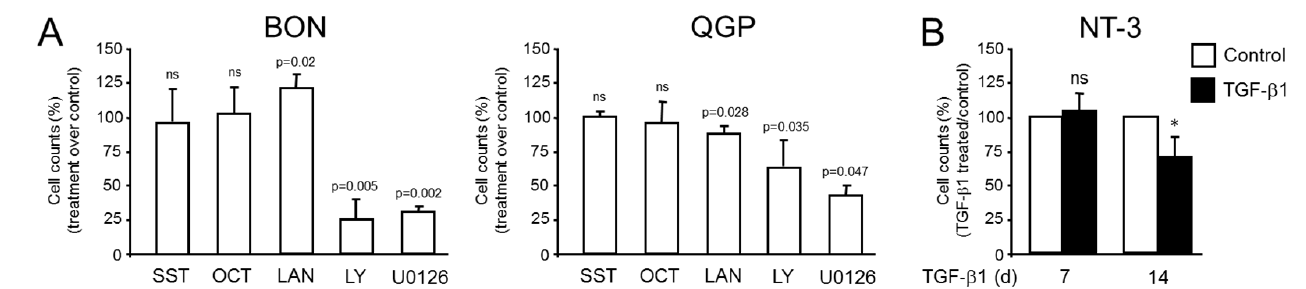
Figure 3. Effect of SST, SSAs, or TGF- β 1 treatment on the proliferative activity of BON, QGP, and NT-3 cells. ( A ) BON and QGP cells were seeded at a density of 50.000 cells per 12-well on day 1 and treated on day 2 with either SST, OCT, or LAN (each at 1 µ M) for 72 h in standard growth medium. Cells in parallel wells were incubated with LY294002 (LY, 50 µ M) or U0126 (10 µ M), both of which served as controls for growth-inhibitory agents. Data are plotted relative to vehicle-treated control cells set at 100% (not shown) and represent the mean ± SD of 3-5 independent assays ( p < 0.05, Wilcoxon test) ( B ) NT-3 cells were challenged with TGF- β 1 (5 ng/mL) for the indicated times (7 or 14 d), and cell counts were subsequently determined. Data shown are the mean ± SD relative to control cells (white-filled bar) set at 100% for both time points (n = 3). The asterisk ( ∗ ) denotes a significant difference ( p < 0.05, Wilcoxon test); ns, non-significant.